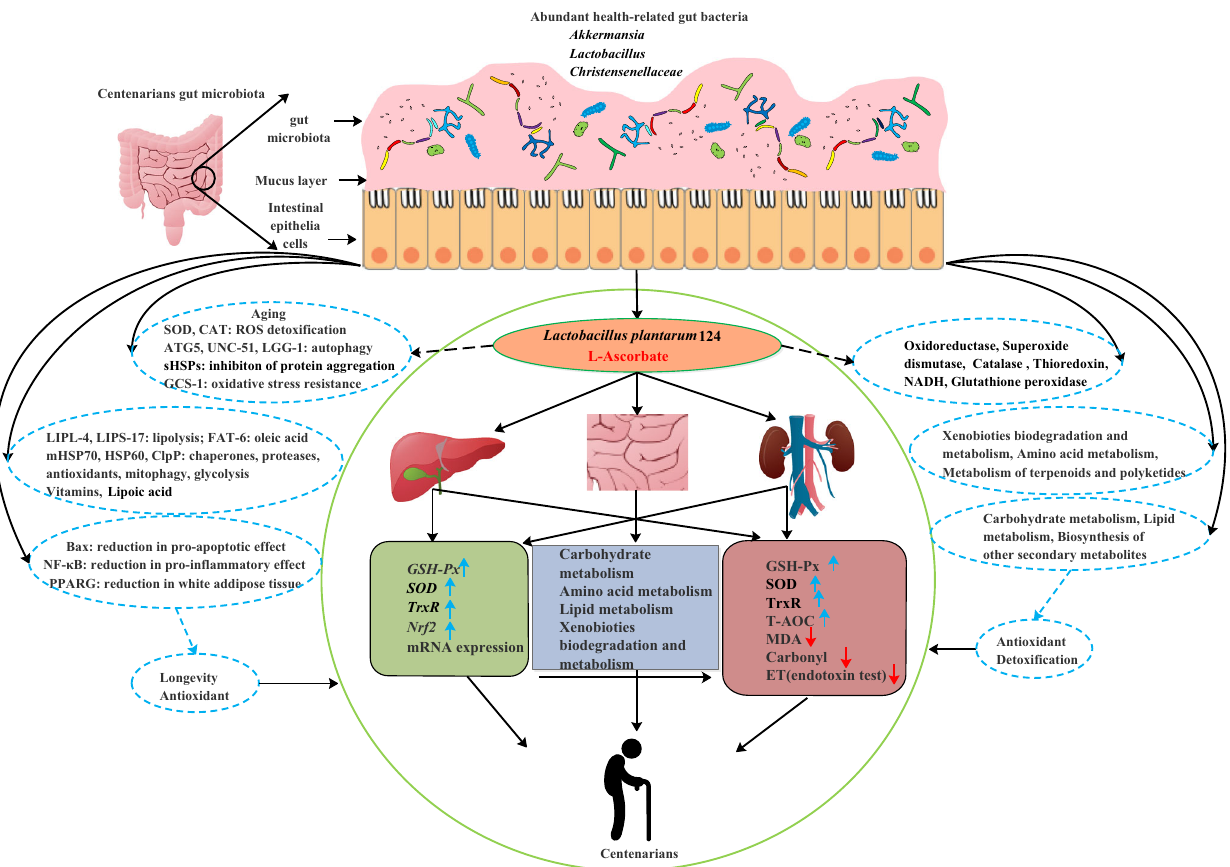
Fig. 9 Structure and function characteristics of gut microbiota in centenarians and potential longevity mechanism. The existence of age- related trajectories in the human gut microbiota, and that distinct gut microbiota and gut-resident as antioxidant systems may contribute to health and